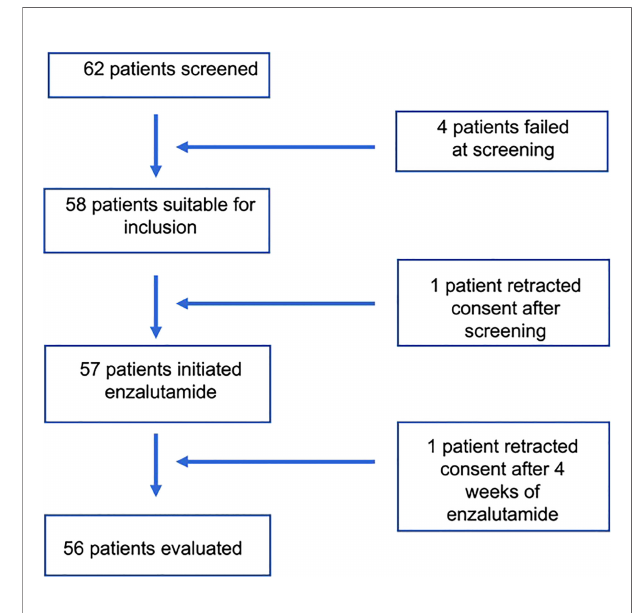
FIGURE 1 | Protocol Flow